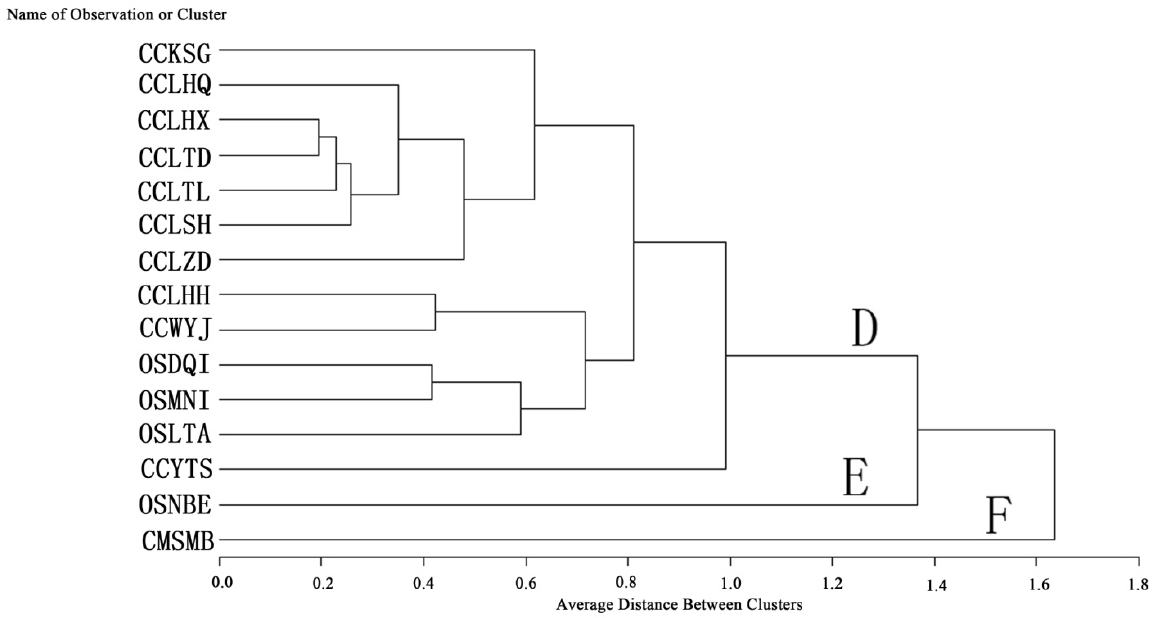
Figure 4. Q-Cluster of 10 nucleosides assayed in sclerotium of 10 populations of C. cicadae , four populations of O. sinensis , and one population of C. militaris by the average linkage